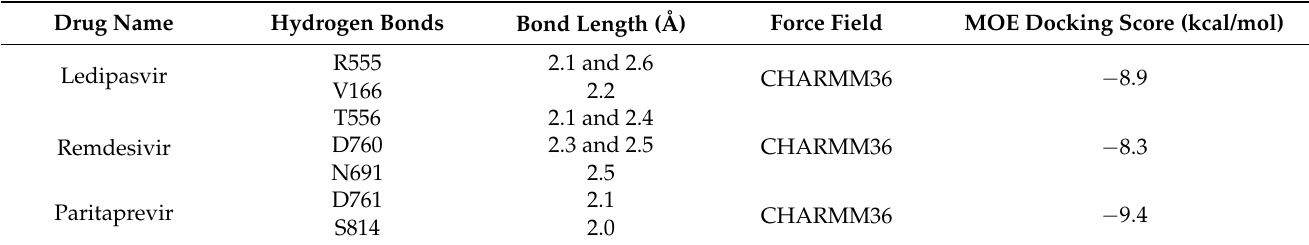
Table 1. Docking scores and hydrogen-bonding interactions with important binding-site